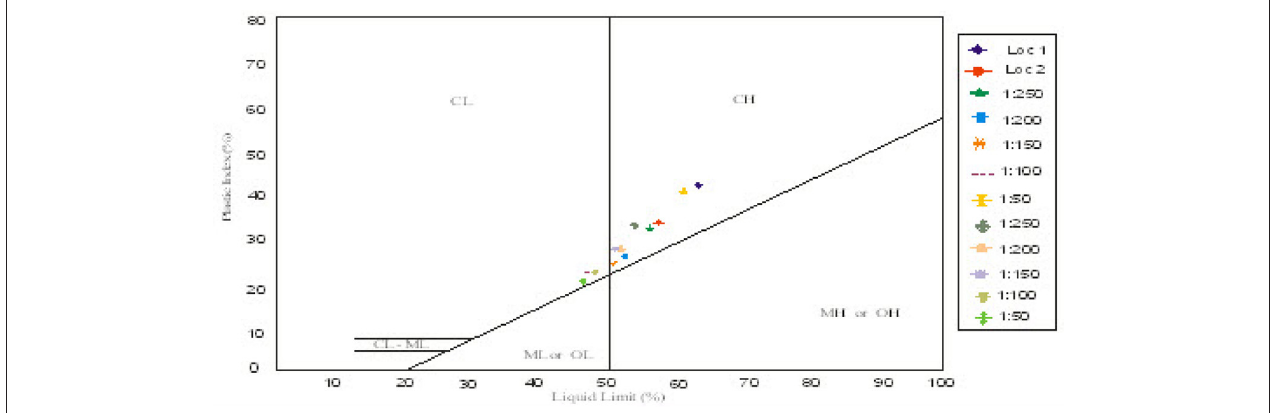
FIGURE 5 | Plasticity chart with unified system.